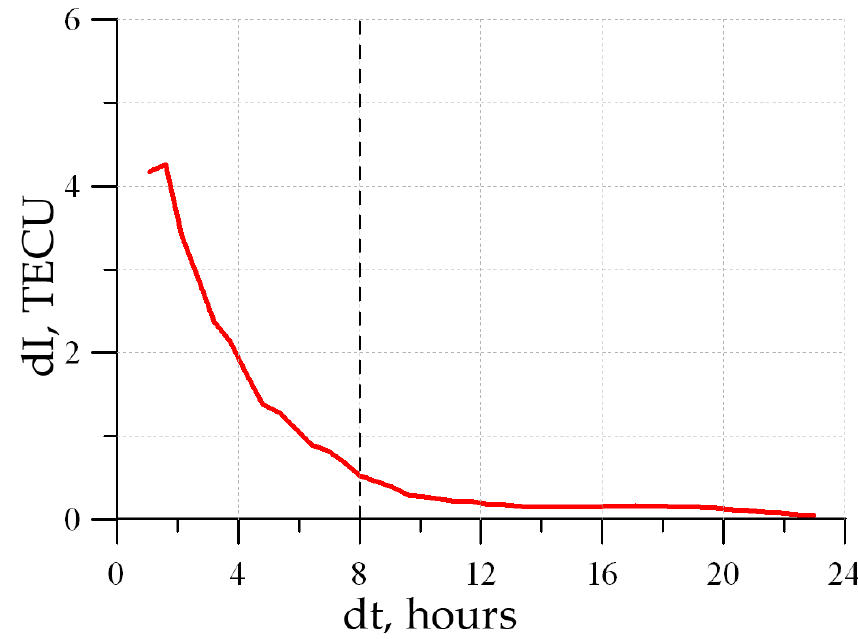
Figure 13. TEC determination error at different times, relative to the receiver ’ s first start. The dotted line marks the reasonable time for the operation start after the receiver ’ s “ cold ” startup (convergence time).